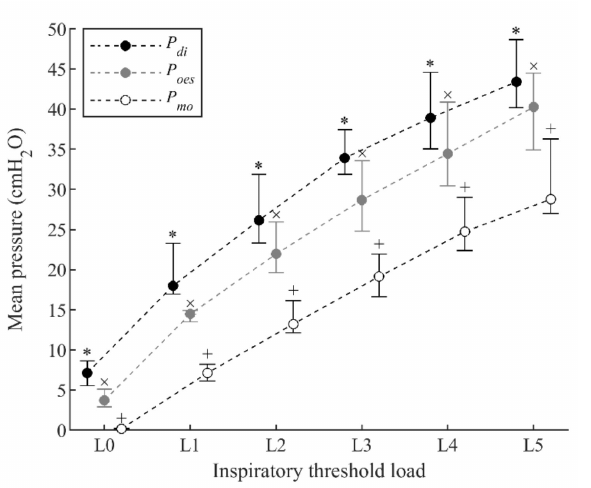
Figure 2. Evolution of respiratory pressures during progressive inspiratory threshold loading. Data points represent median and interquartile (IQR) range of the 12 subjects for each load. All data points with the same symbol (*, × , or +) were significantly different to each